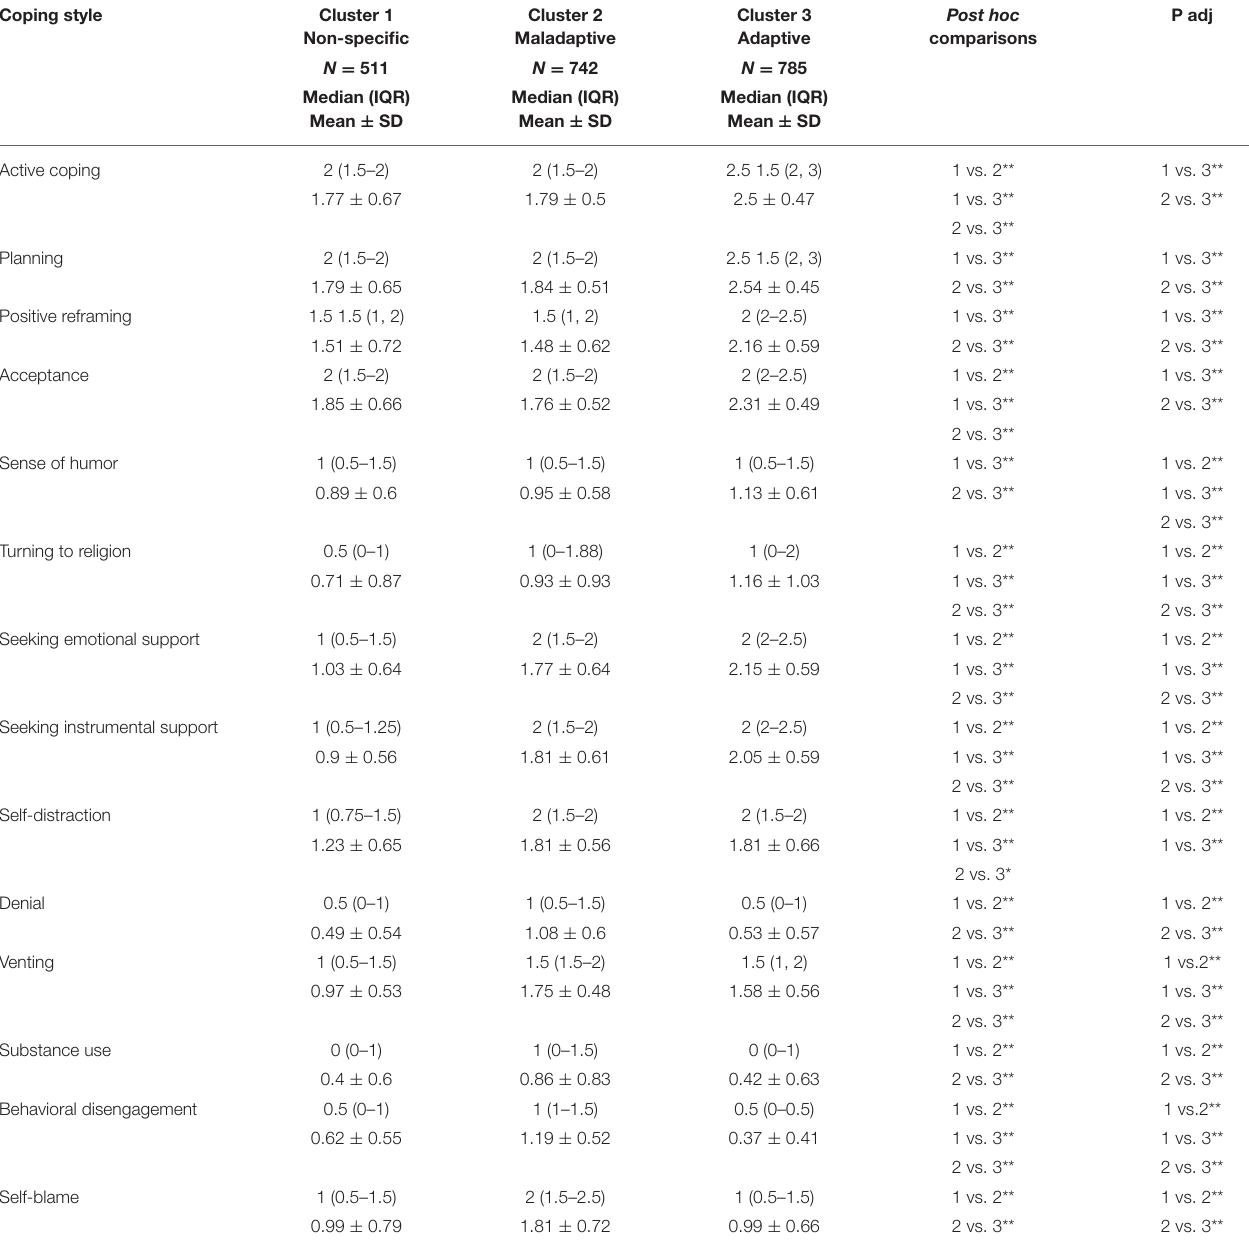
TABLE 1 | Detailed characteristics of the clusters regarding coping strategies. Coping